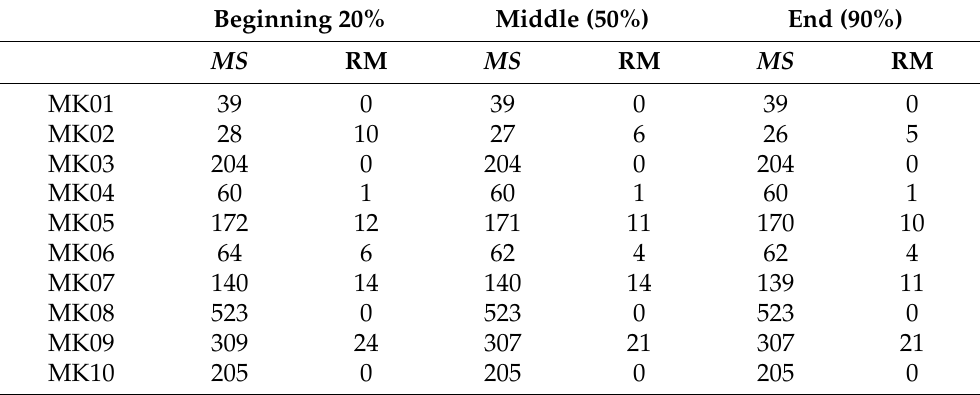
(Table 11: adaptive E2L-PSO with medium reduction and E2L-PSO without CPU reduction needed) are shown in Table 14. Table 14. Robustness analyses of E2L-PSO with medium CPU reduction needed (40%) on Raspberry Pi